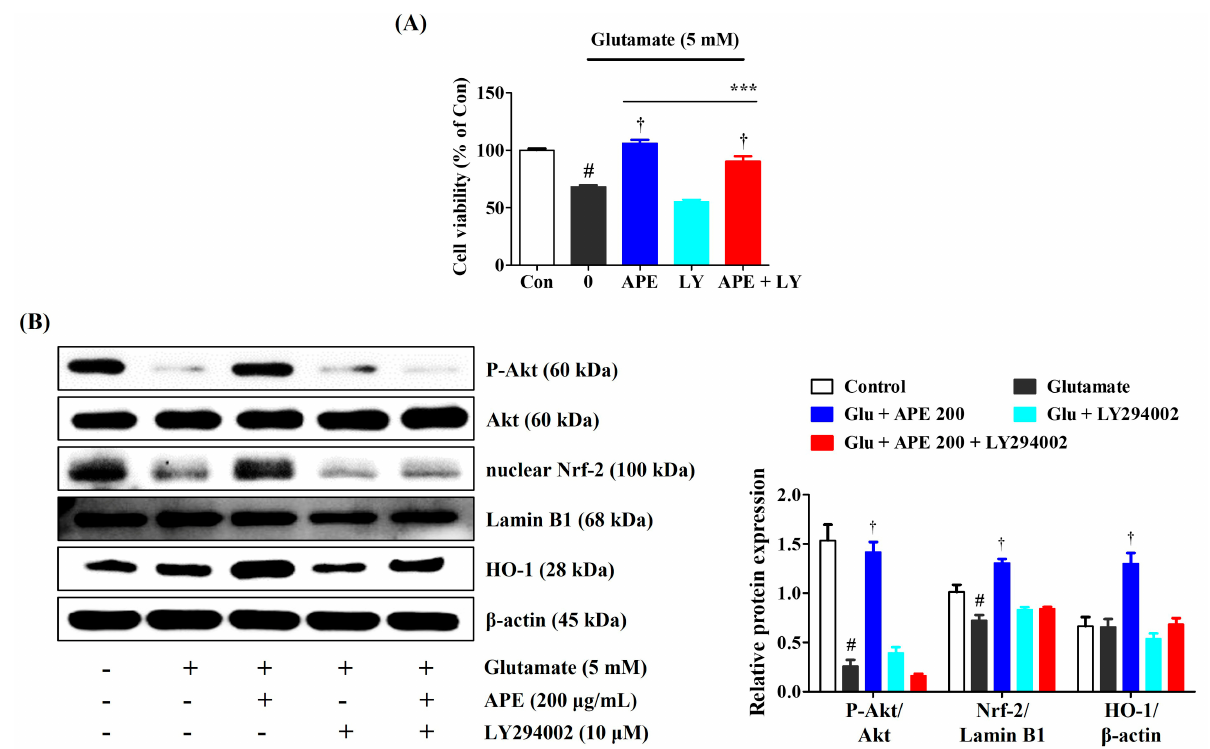
Figure 7. The suppressive effects of LY294002 on the neuroprotective action of Arecae Pericarpium ethanol extract. HT22 cells were incubated with or without APE combined with LY294002 before glutamate treatment. ( A ) Cell viability and, ( B ) Activation of protein kinase B, Nrf-2, and HO1 were assessed using a cell-counting kit assay and Western blot analysis, respectively. Control was non-treated cells. Blot images represent the three independent experiments. Data were presented as mean ± standard error of the mean. Statistical significance was set at # p < 0.05 (vs. control), † p < 0.001 (vs. glutamate), and *** p < 0.001 (vs. APE). Akt, protein kinase B; APE, Arecae